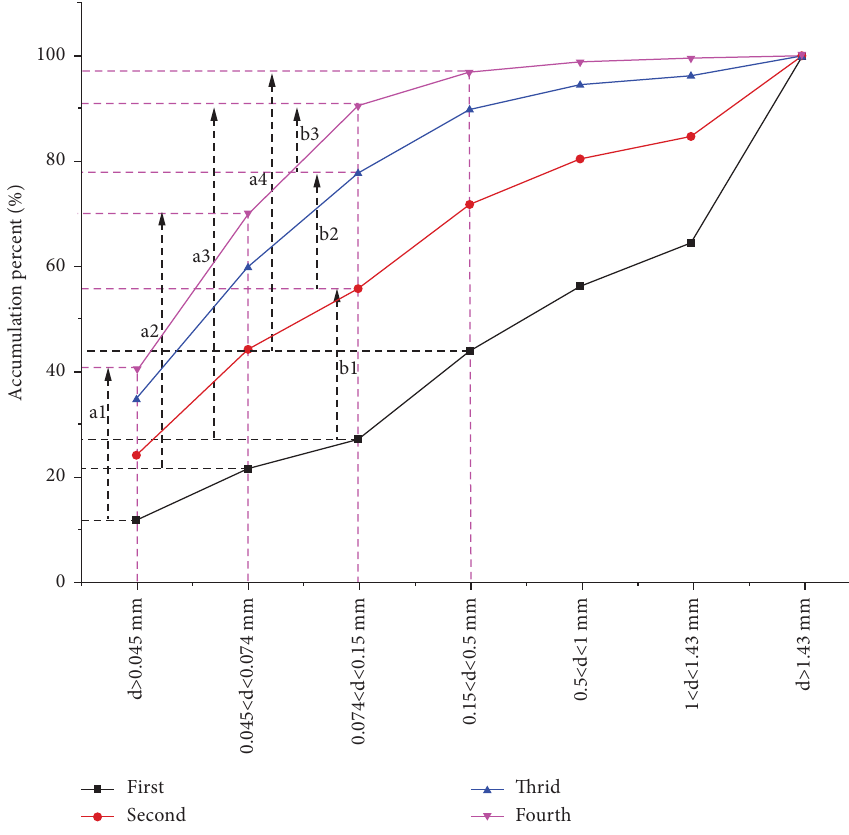
Figure 5: Te cumulative size distribution of the frst group of cyclic powdering (diasporic bauxite). Table 3: Te quality of the bauxite ore in the second group of circulating